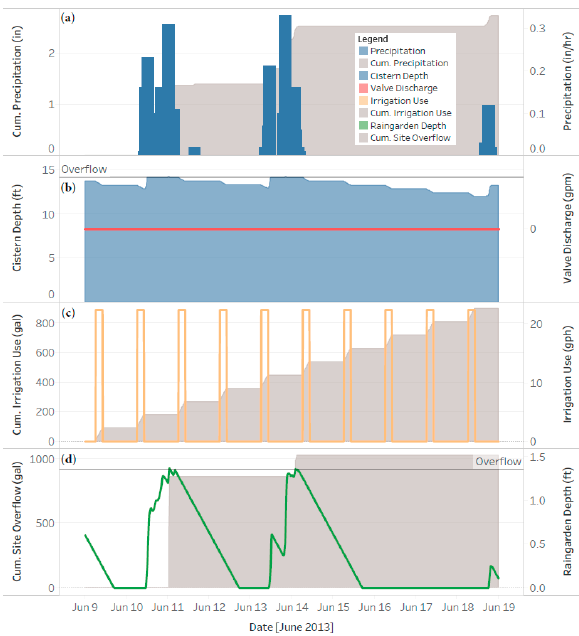
Figure 3. Timed Scenario Performance (9 June 2013–19 June 2013): ( a ) Rainfall occurred on 10 June 2013 and 13 June 2013; ( b ) The cistern’s water level decreased daily from scheduled irrigation, but overflowed to the raingarden during both rainfall events; ( c ) Scheduled irrigation occurred each day, including during rainfall; ( d ) The raingarden overflowed to the site outfall during both rainfall events despite beginning each event empty.